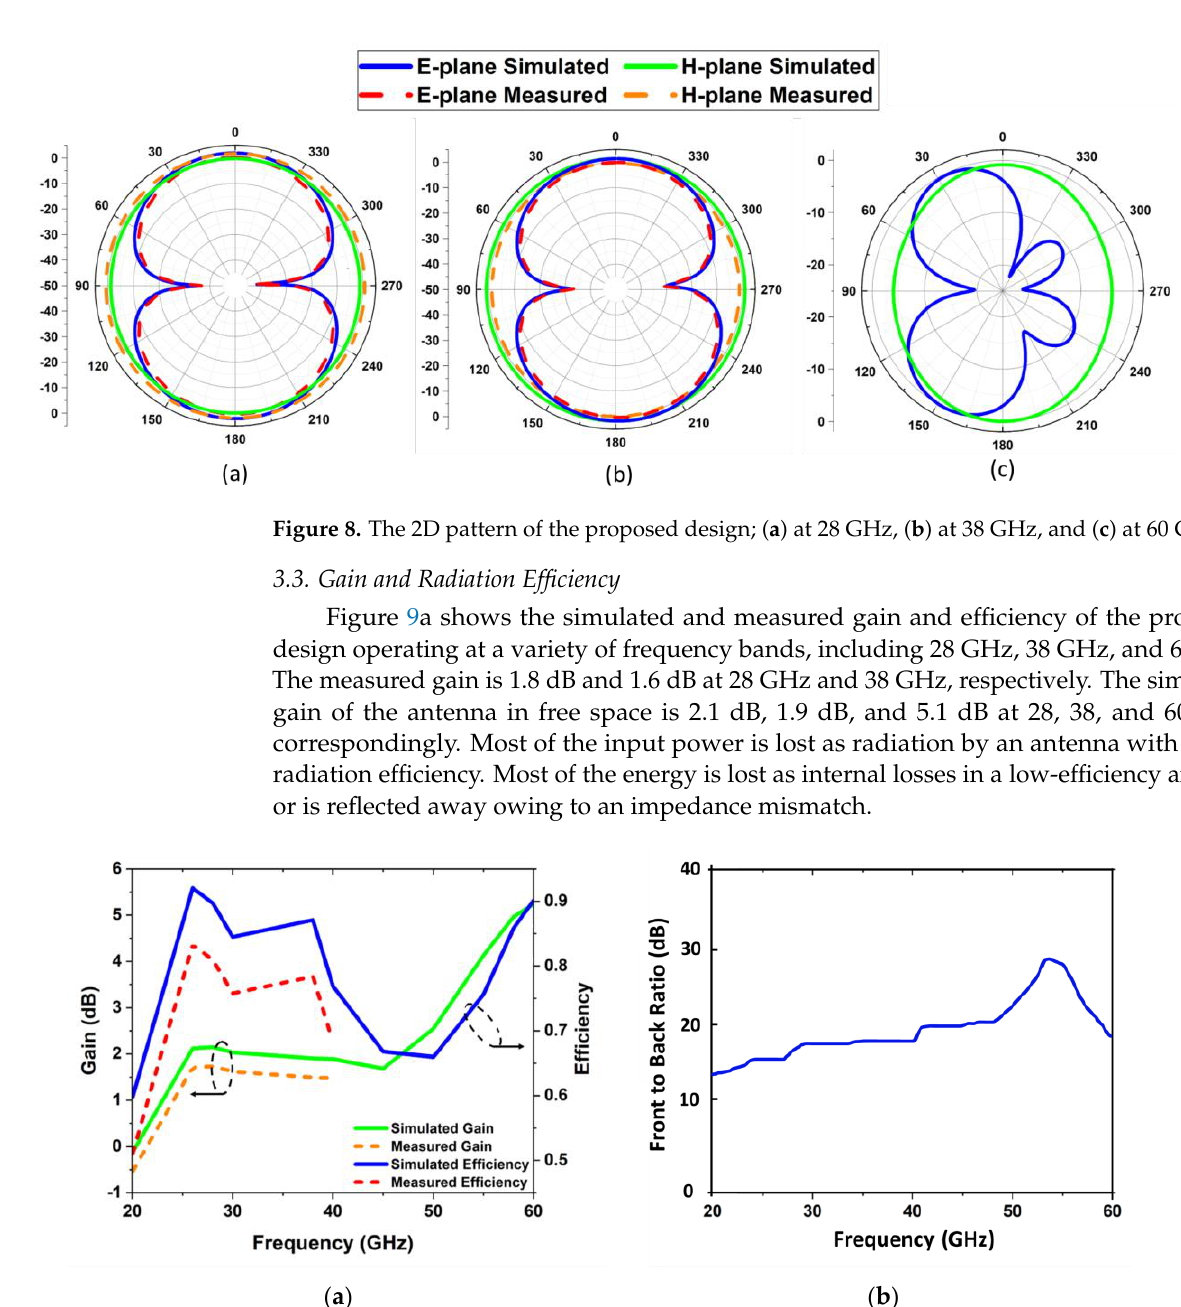
9 of 14 Figure 7. ( a ) The prototype of the proposed antenna; ( b ) comparison between the simulated and measured return loss. 3.1. Measurement Setup The R&S ZVA110 Vector Network Analyzer (VNA) (Rohde & Schwarz, Munich, Germany) is utilized to investigate and verify the proposed tri-band antenna ’ s frequency domain reflection coefficient. Far-field radiation parameters of the proposed design are analyzed using a shielded RF anechoic chamber. A standard 24 dBi horn antenna (SGH-series) is utilized as a transmitter while the proposed antenna design is used as a receiver. Transmission losses and open air may affect the signal produced by a volt- age-controlled oscillator (VCO). Measurement set-up employed high-gain power ampli- fiers, which can boost the produced signal and efficiently transmit the radio signal from transmitter to receiver. 3.2. Radiation Pattern Figure 8a – c illustrates the radiation pattern of the proposed antenna at various res-